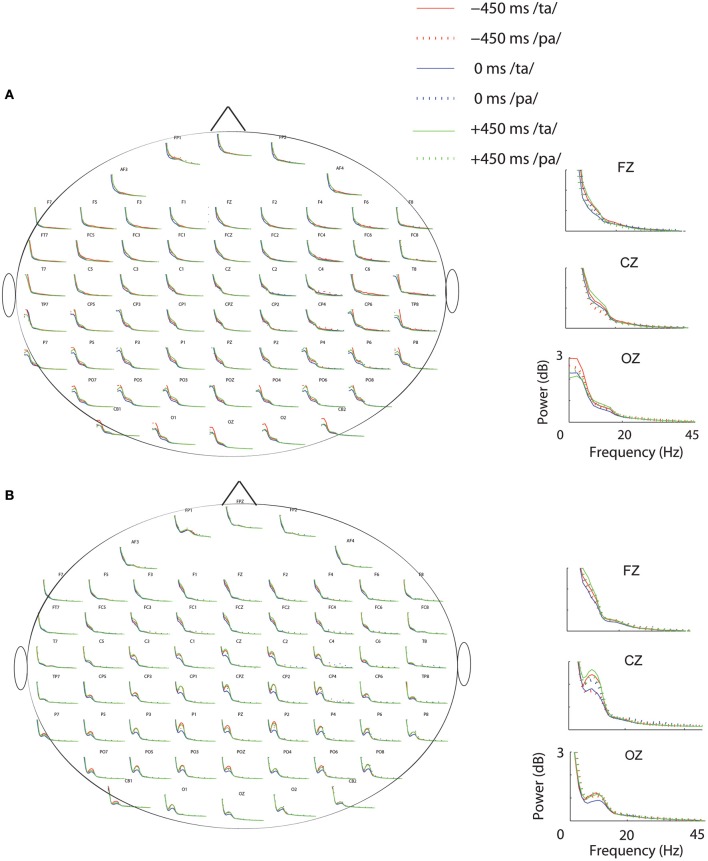
Power Spectrum. Spectral-power at each condition and perceptual category during (A) Pre-stimulus onset. (B) Post-stimulus onset periods. The plots adjacent to the scalp maps show the enlarged plots of the power spectrum at the sensors: Fz, Cz, and Oz.